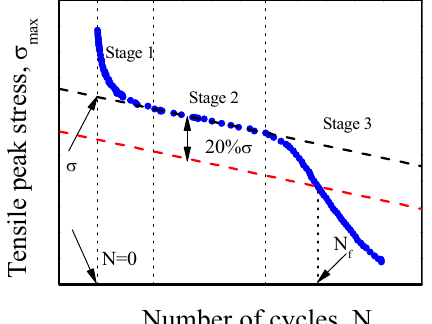
Figure 3: De fi nition of fatigue life N f